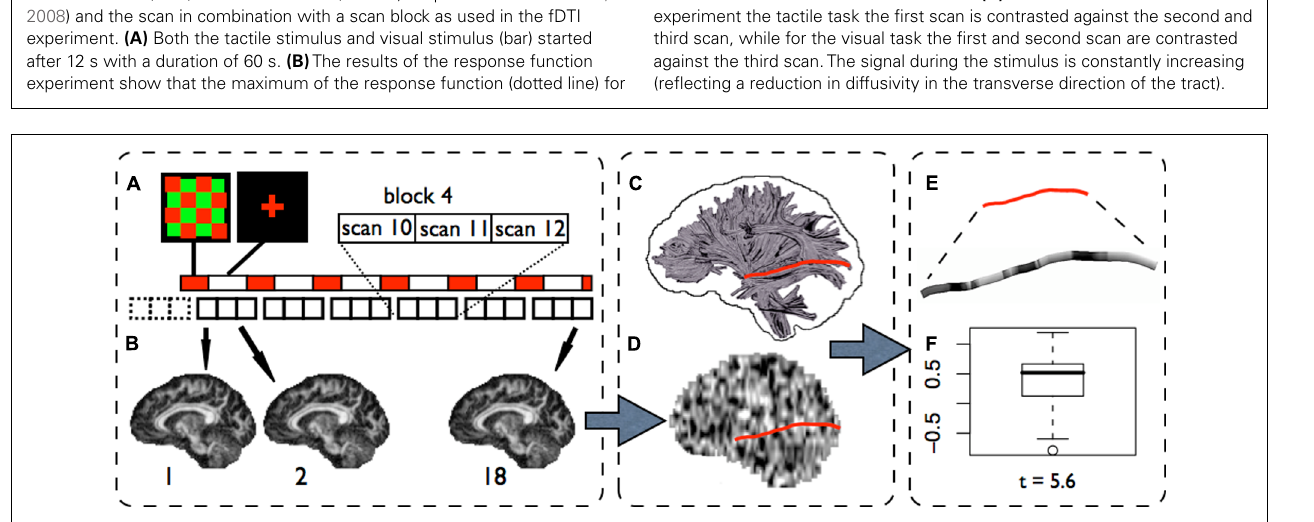
FIGURE 1 | Response functions and task encoding. The graphs represent the time course of the measured diffusion weighted MRI signal for a single tactile stimulus (dots) or visual stimulus (dashes; adapted from Mandl etal., 2008) and the scan in combination with a scan block as used in the fDTI experiment. (A) Both the tactile stimulus and visual stimulus (bar) started after 12 s with a duration of 60 s. (B) The results of the response function experiment show that the maximum of the response function (dotted line) for